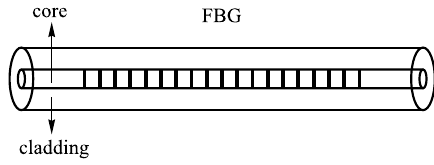
Fig. 1 Schematic diagram of the fiber Bragg grating (FBG)